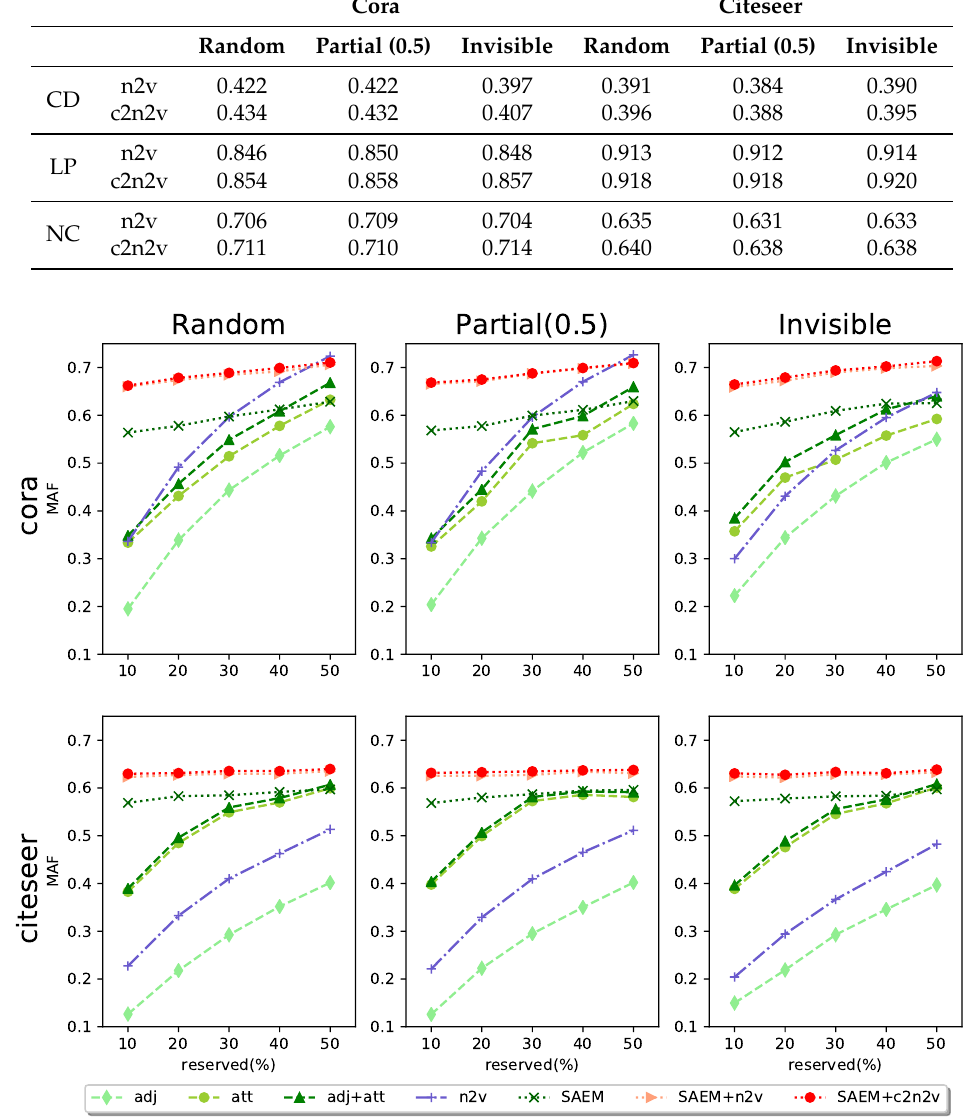
Figure 4. Results of Macro-F1 (MAF) scores on node classification for three privacy settings and three